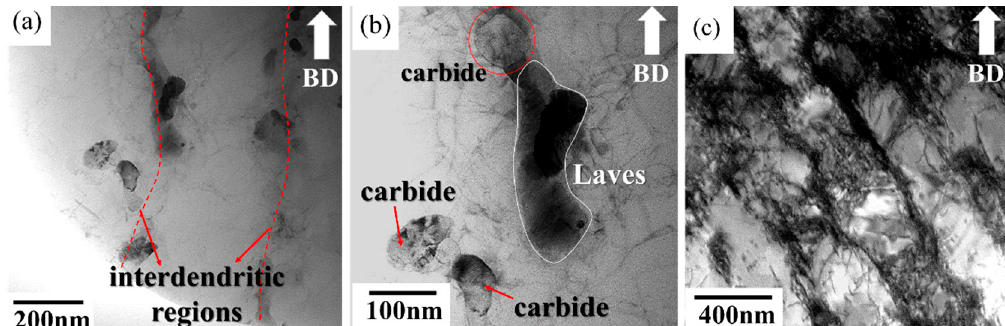
Figure 1. Secondary electron images of the as-built specimen: ( a ) lower magnification showing the molten pools structure and ( b ) higher magnification showing dendritic structures. The build direction with respect to the plane of the images is shown with an arrow.